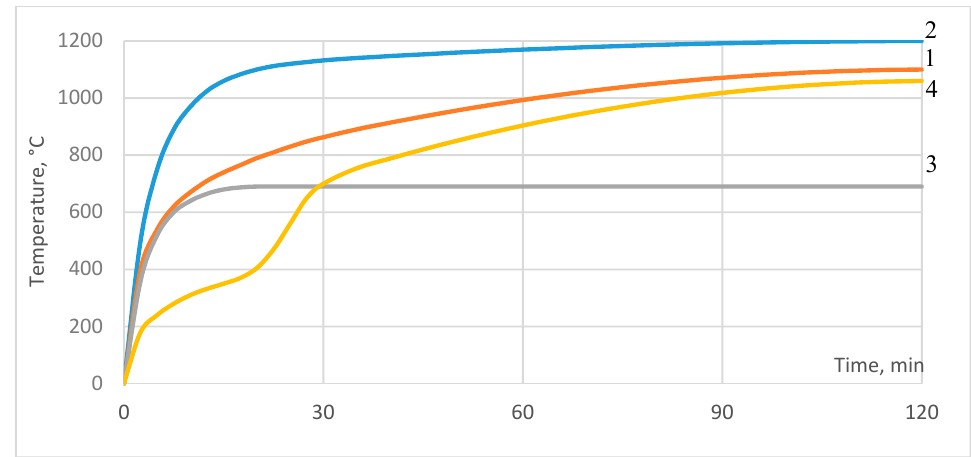
Figure 1. Fire curves according to EN 1363-2:1999 [7]: 1—standard time-temperature curve; 2— hydrocarbon curve; 3—external fire exposure curve; 4—slow heating curve.